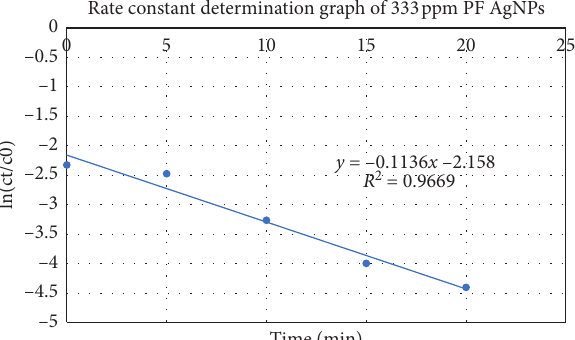
Figure 30: Rate constant graph of 333ppm PF